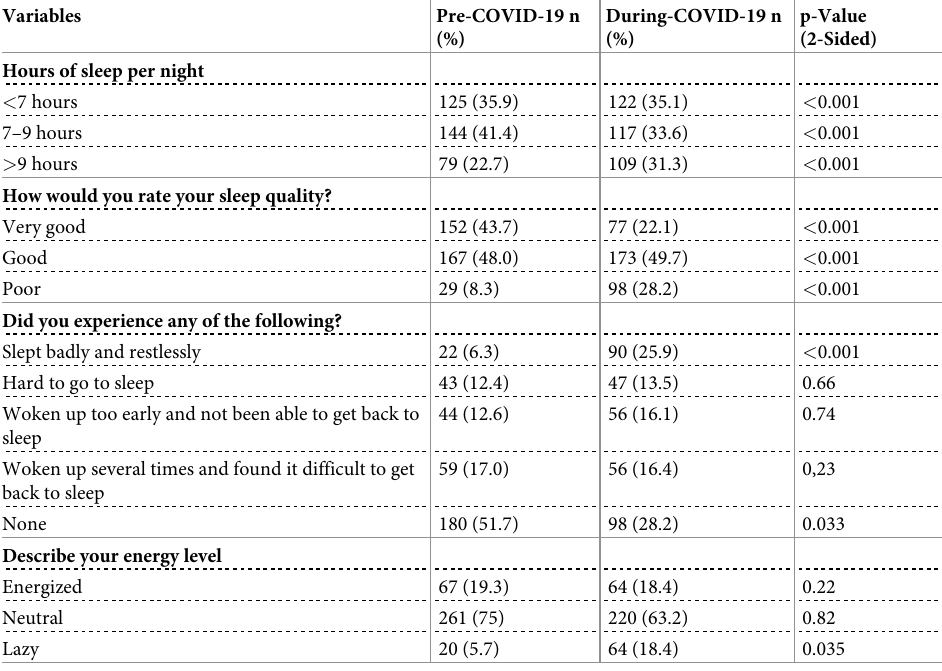
Table 7. Sleep status of the respondents during COVID-19